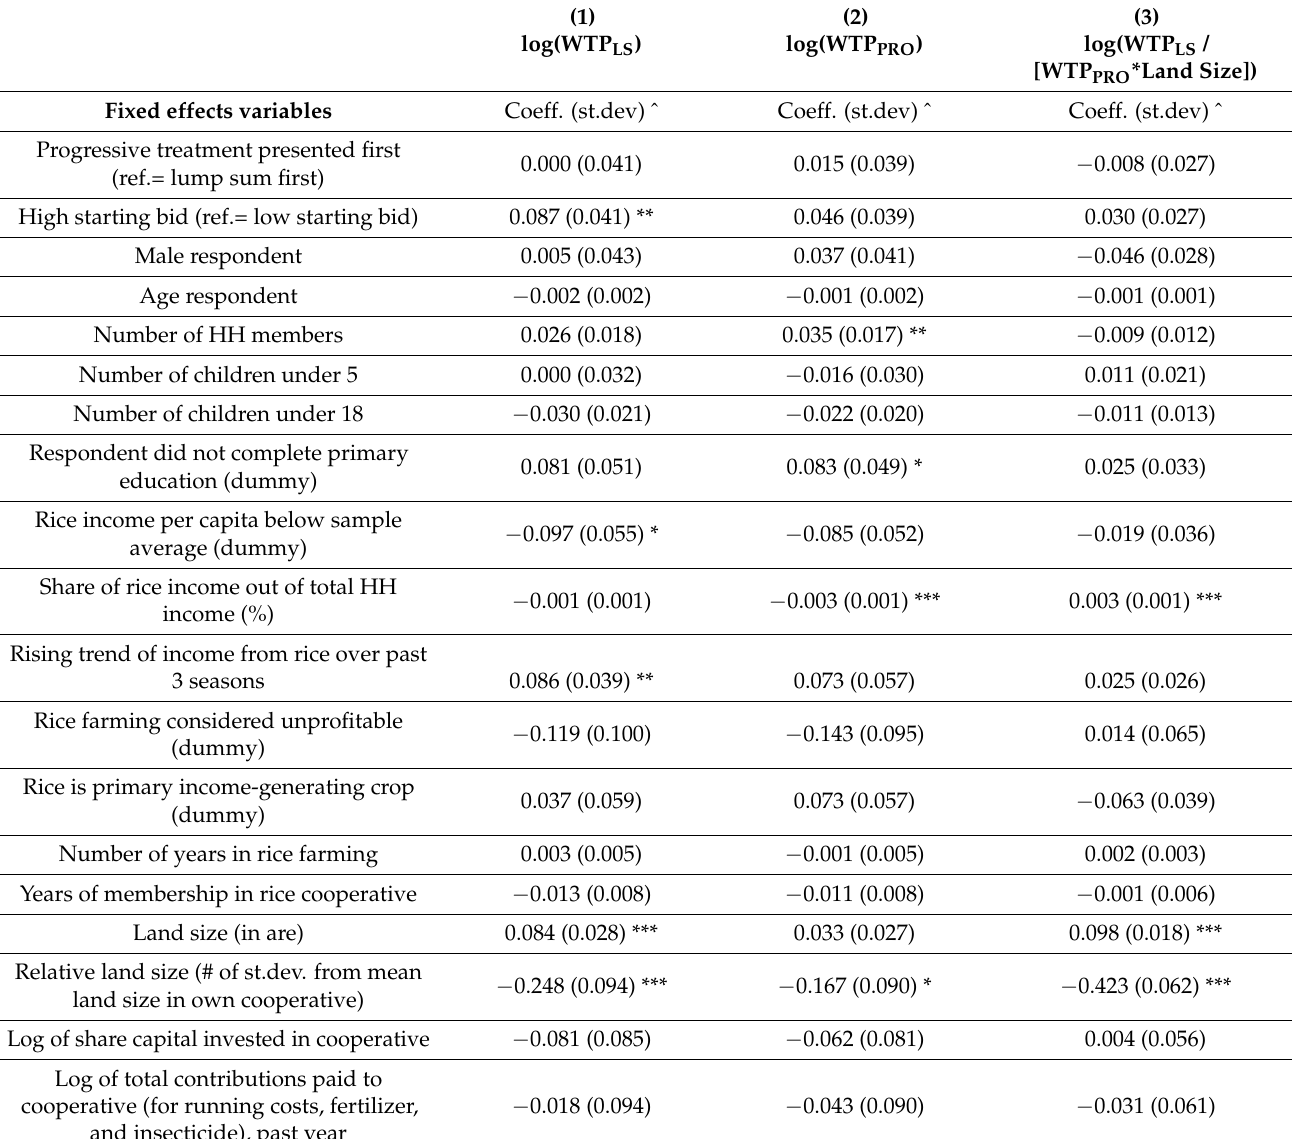
Table 3. Linear mixed effects regression results: WTP determinants (lump-sum, progressive, and